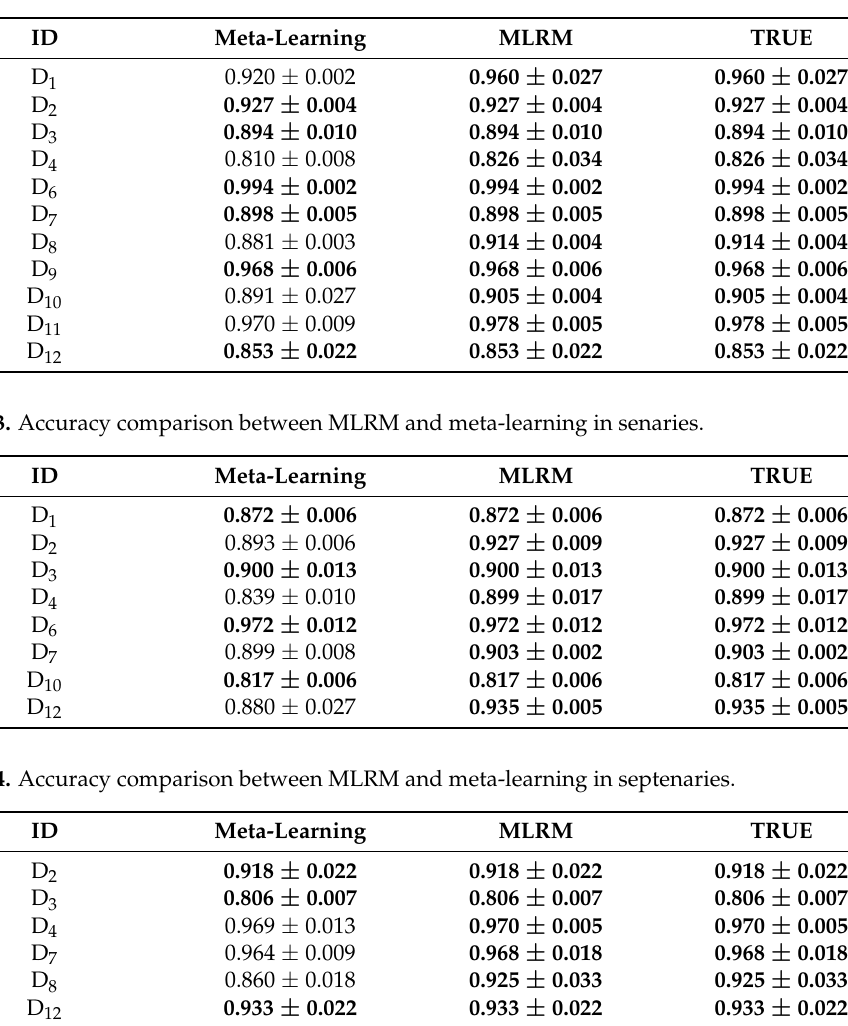
Table 12. Accuracy comparison between MLRM and meta-learning in quinaries.